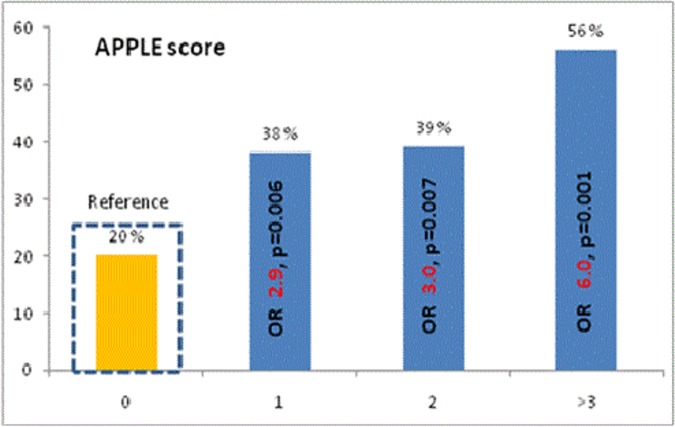
APPLE score and risk for arrythmia recurrences in repeat catheter ablation in whole study population (n = 379).The figure presents incidence of arrhythmia recurrences (%) according to each APPLE score point. Compared to patients with an APPLE score of 0 (reference), the risk (OR) for arrhythmia recurrences was 2.9 (95% CI 1.4–6.3, p = 0.006), 3.0 (95% CI 1.3–6.6, p = 0.007) and 6.0 (95% CI 2.2–16.8, p = 0.001) for APPLE scores 1, 2, or ≥3, respectively.